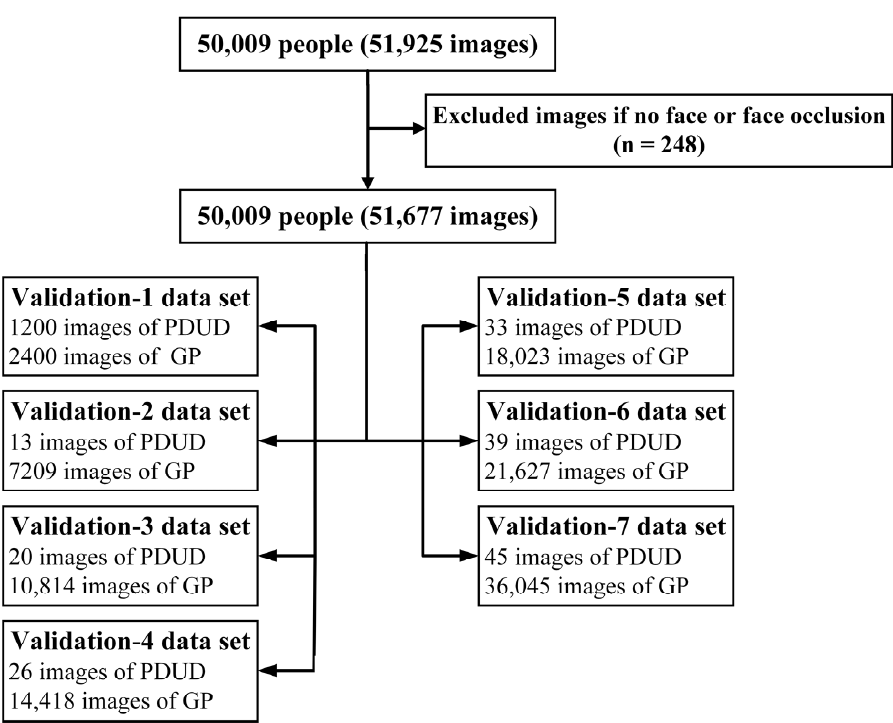
Figure 3. The flow of external validation datasets collection and data distribution in each validation dataset.